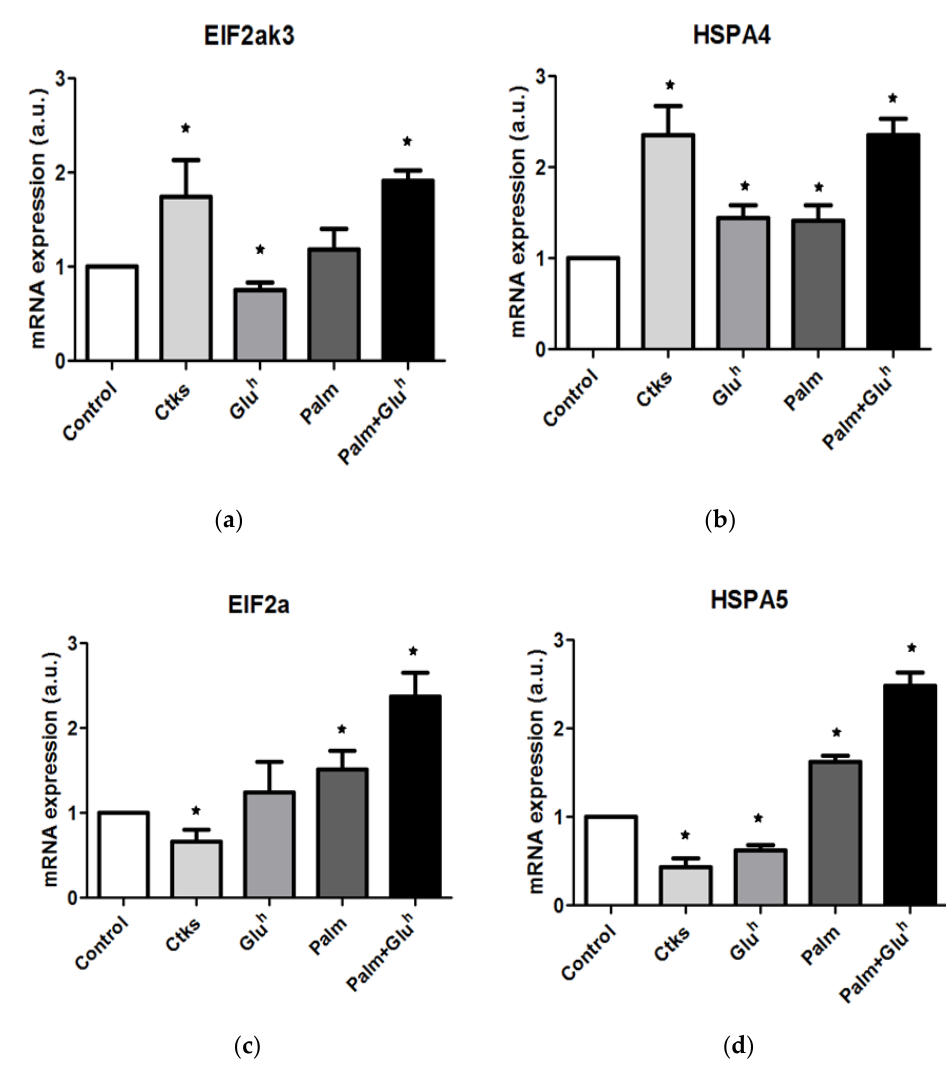
Figure 3. Cytokines, palmitate, high glucose, and high glucose+palmitate effect on ER stress response markers. EIF2AK3, ( a ) HSPA4, ( b ) EIF2a, ( c ) and HSPA5 ( d ) mRNA expression were measured in 48 h cultured 1.1E7 cells with or without the cited treatment. Results are presented as the mean ± SEM of the mRNA expression indicated as arbitrary units relative to the control. Values were obtained from at least four independent experiments. * p < 0.05 with respect to the control